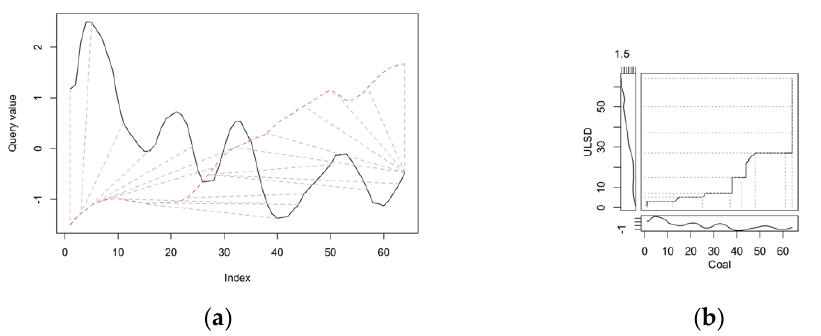
Figure 15. Alignment plots for coal and ULSD for the third subperiod. ( a ) Two-way, ( b ) Three- way. On the two-way plot the black solid line for coal, the red dashed line for ULSD. Source: own elaboration on the basis of data from www.stooq.com (accessed on 19 April 2021).